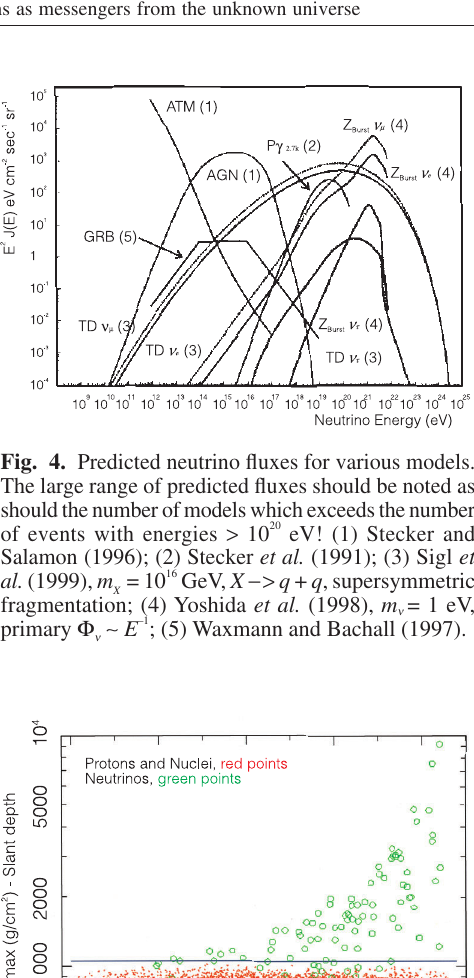
Fig. 5. Shower depth distribution from Monte Carlo simulations showing how neutrino and proton and nuclei induced events can be